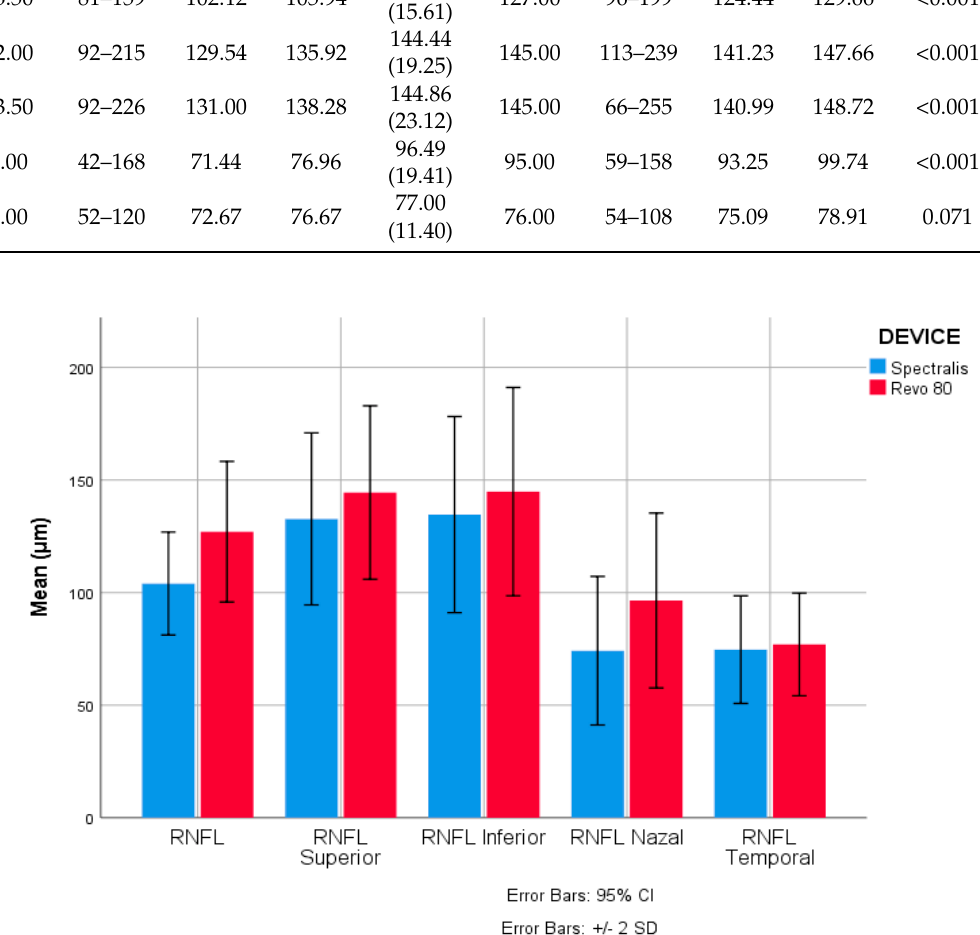
Figure 2. Clustered bar chart displaying the differences between mean values of global and sectorial RNFL in Spectralis and Revo80.